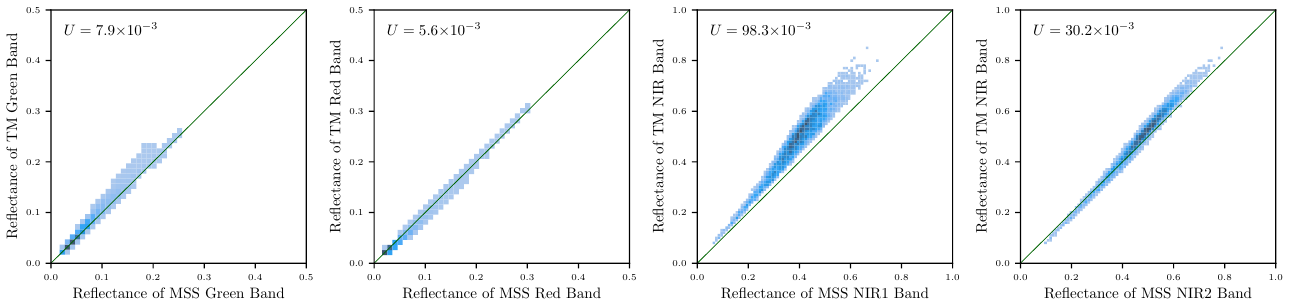
Figure 5. PROSAIL effective reflectance comparison of Landsat 5 MSS and